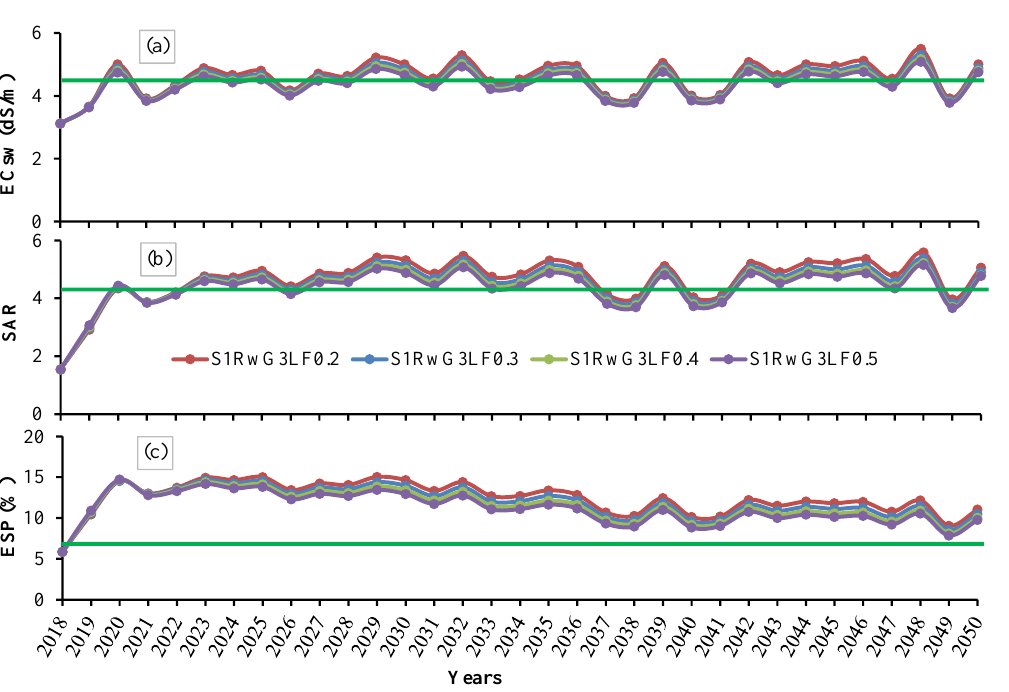
Figure 5. Impact of different leaching fractions (LF0.2, LF0.3, LF0.4, and LF0.5) and annual gypsum applications of 8.6 t/ha (G3) on ( a ) EC sw , ( b ) SAR, and ( c ) ESP in the 0–15 cm soil layer of the calcareous soil (S1) under recycled water (RW) irrigation of wine grapes.